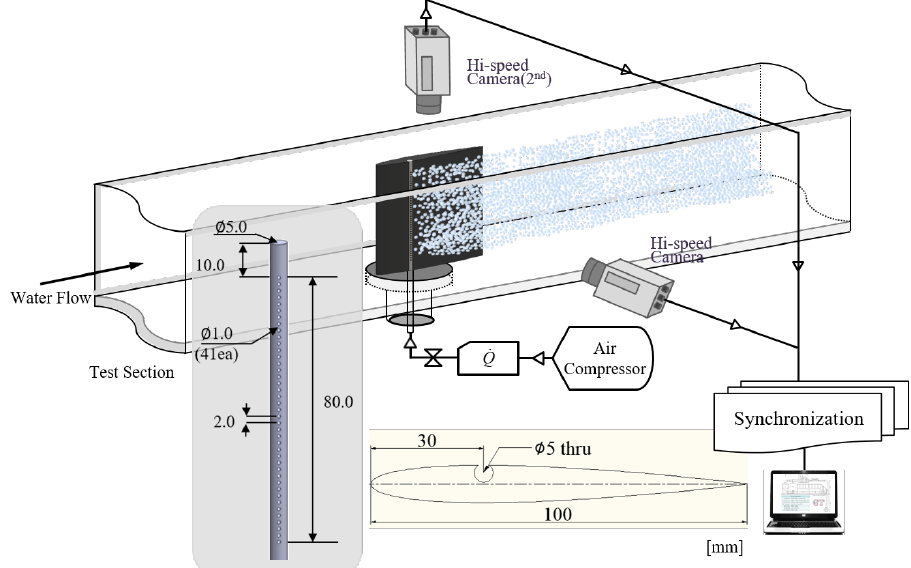
Figure 1. Schematic of the current experimental setup. Detail of the air injection vents is shown in the